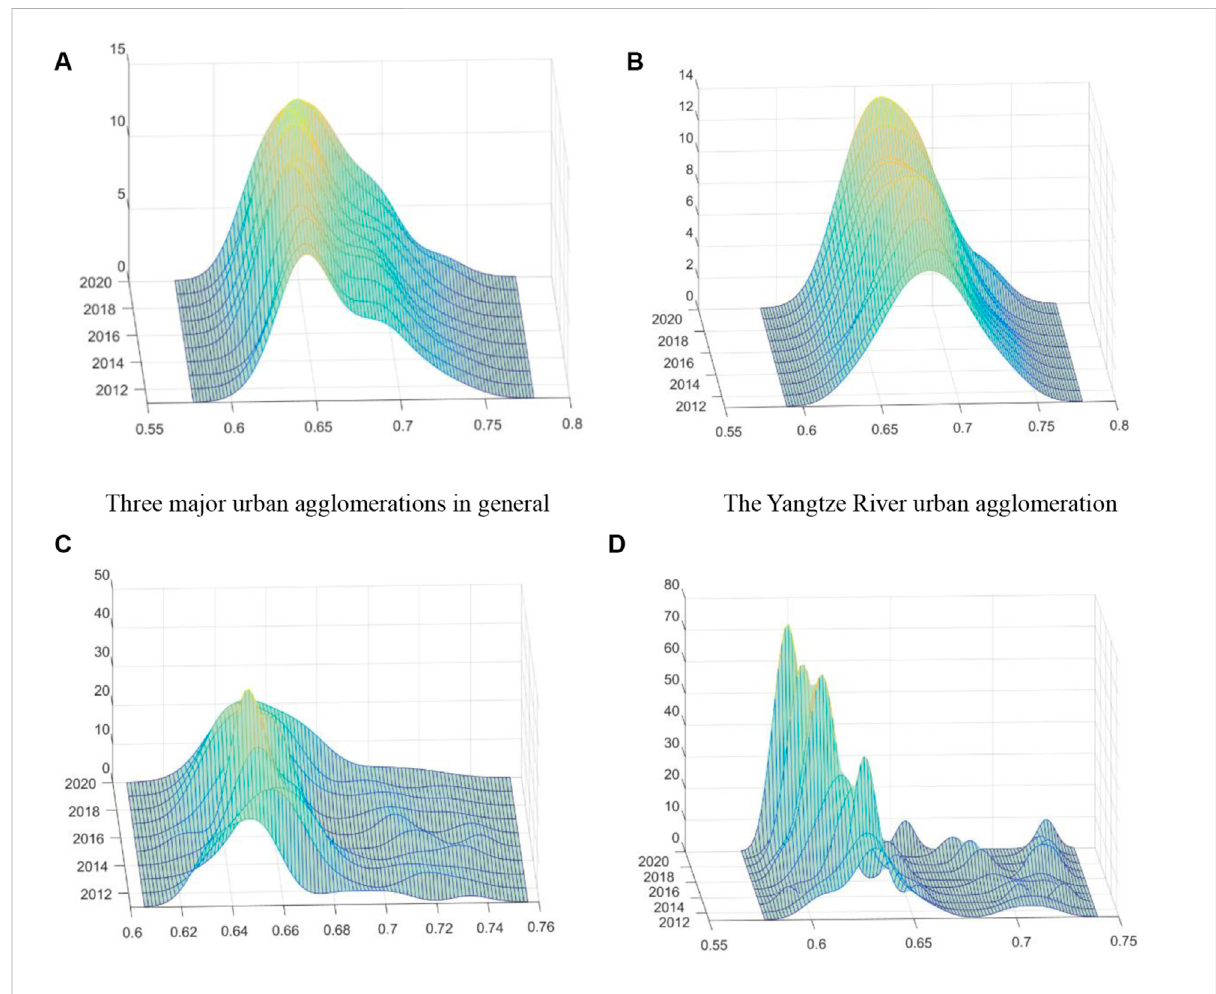
FIGURE 3 Dynamics of the distribution of economic high-quality development levels of the three major urban agglomerations in the Yangtze River Economic Belt. (A) Three major urban agglomerations in general (B) The Yangtze River urban agglomeration. (C) the middle reaches of the